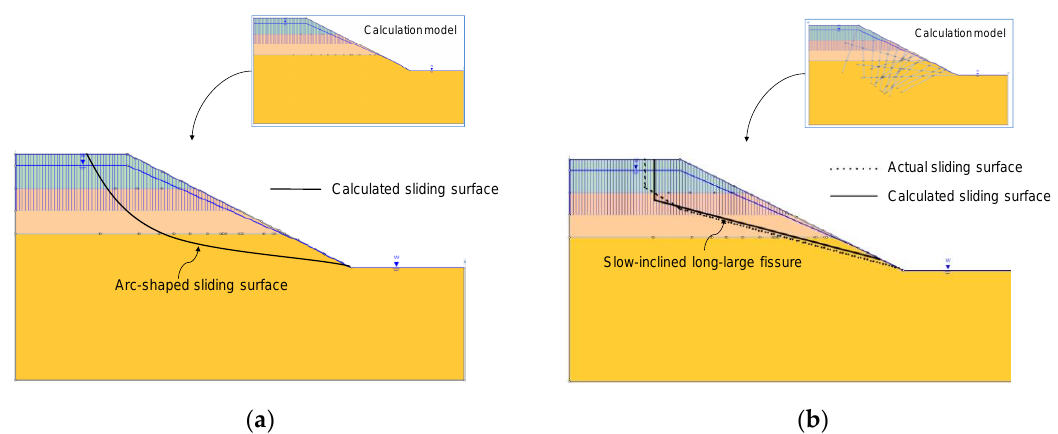
Figure 11. Calculate sliding surface and actual sliding surface. ( a ) Homogeneous expansive soil slope; ( b ) expansive soil slope with filled fissures.